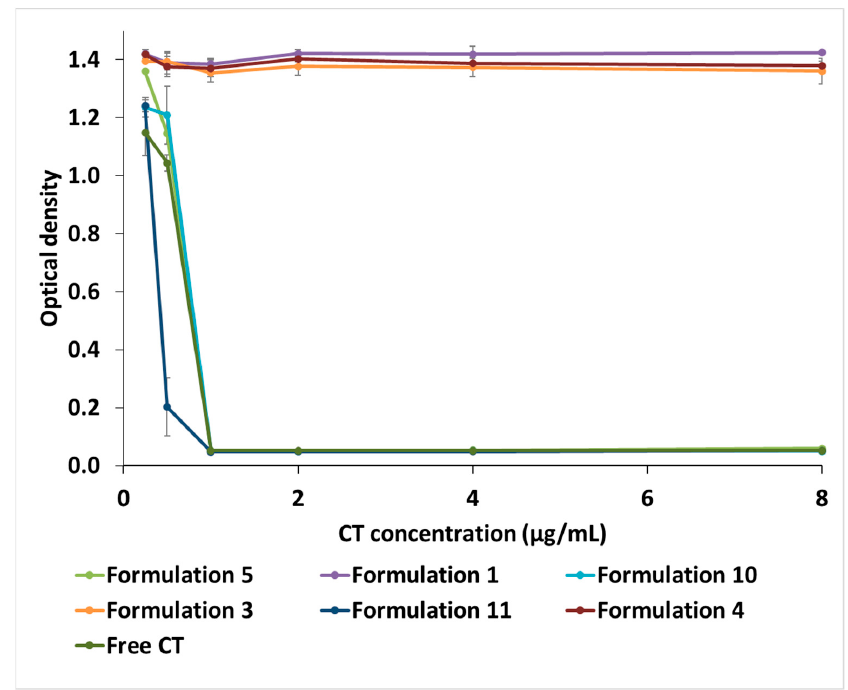
Figure 4. The minimum inhibitory concentrations (MIC) of CT-HA-DEAECS and HA-DEAECS PECs against Pseudomonas aeruginosa. Error bars indicate standard deviations (n = 3).